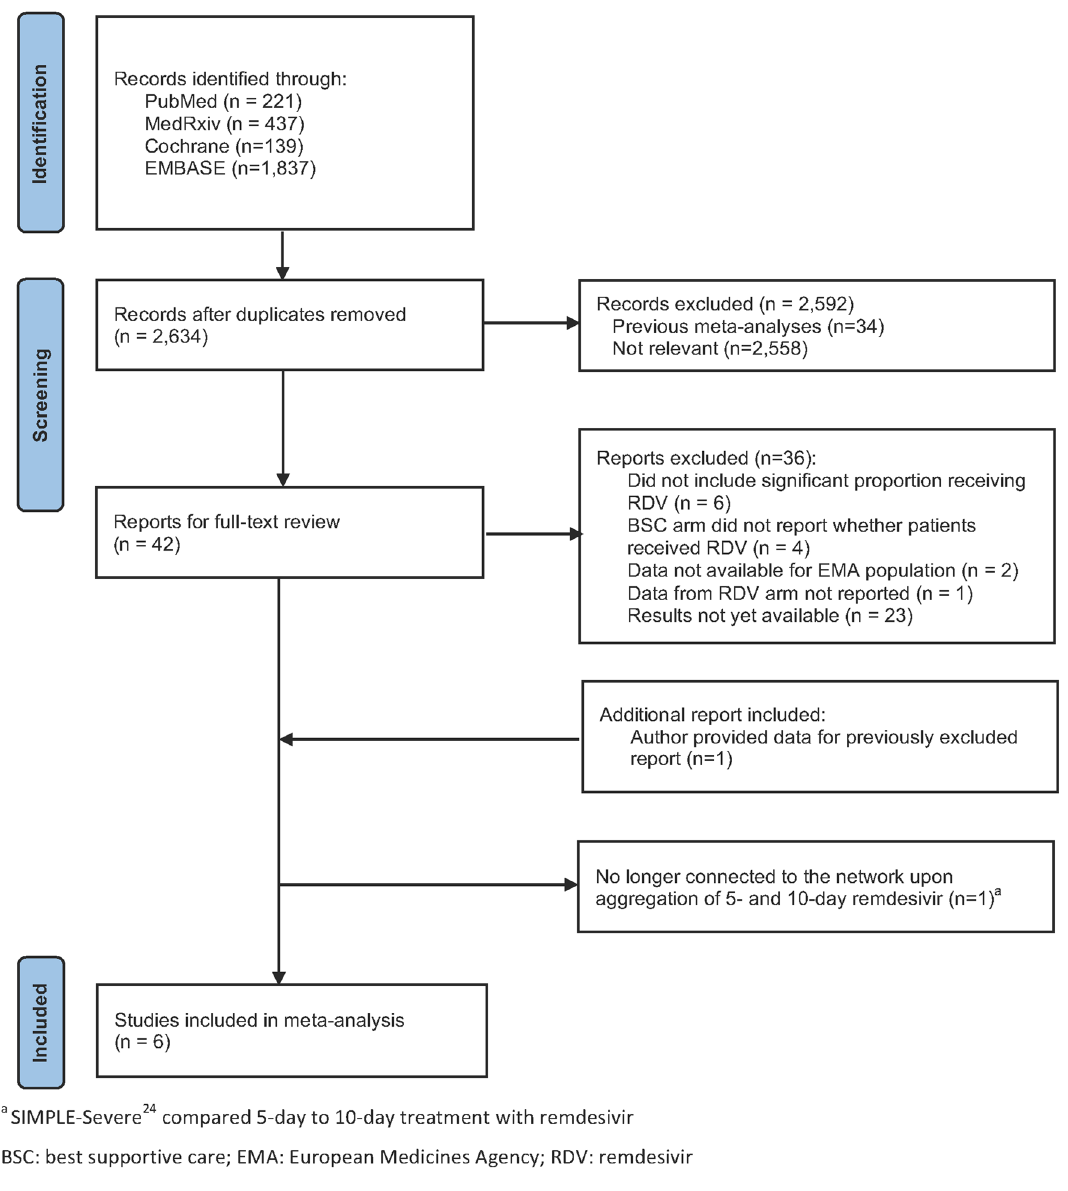
Figure 1. PRISMA study selection flow